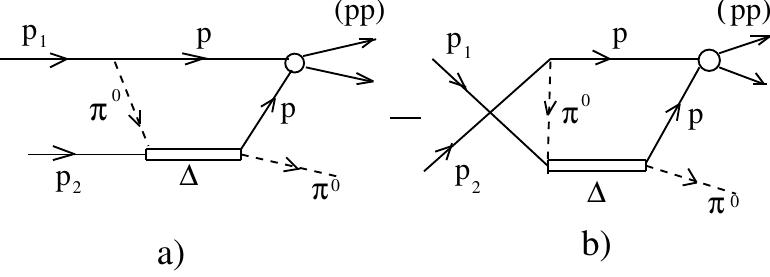
Figure 3. The ∆ -isobar mechanism of the reaction pp → { pp } s π 0 with the direct (a) and exchange (b)